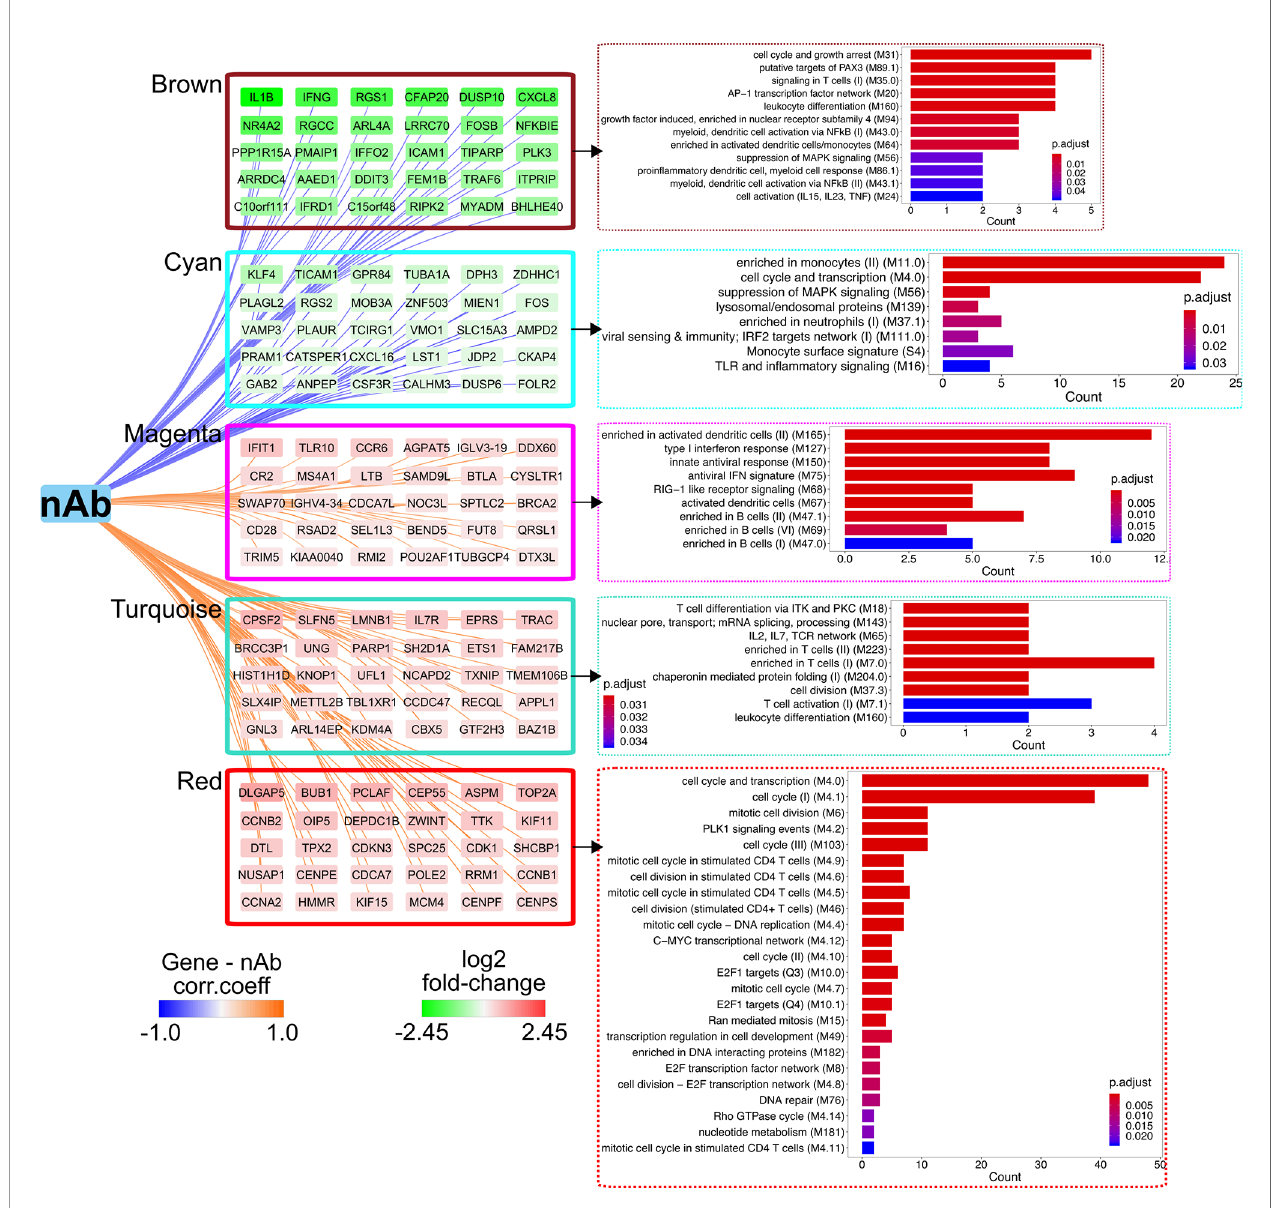
FIGURE 3 | Weighted gene co-expression network analysis (WGCNA) identi fi es a co-expression network and critical genes associated with neutralizing antibody (nAb) production. Correlations of log 2 fold change of individual genes in the brown, cyan, magenta, turquoise, or red modules with antibody (Ab) titer. Edge width denotes the correlation strength and node color represents the log 2 fold change (day 14/day 0). Blood transcriptional modules (BTMs) enriched in each module as assessed by clusterPro fi ler are shown. Bar plots display the number of genes in each BTM, with genes ranked by the adjusted p -value for